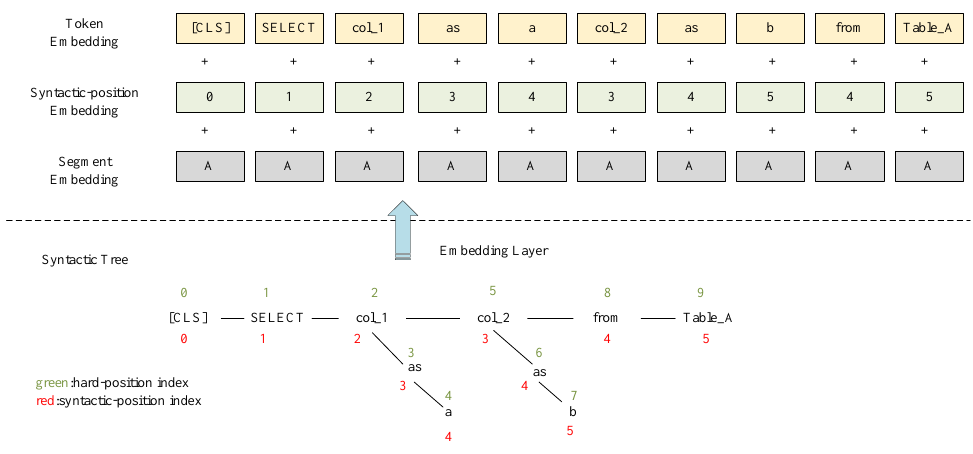
Figure 4. Three embeddings of the input.